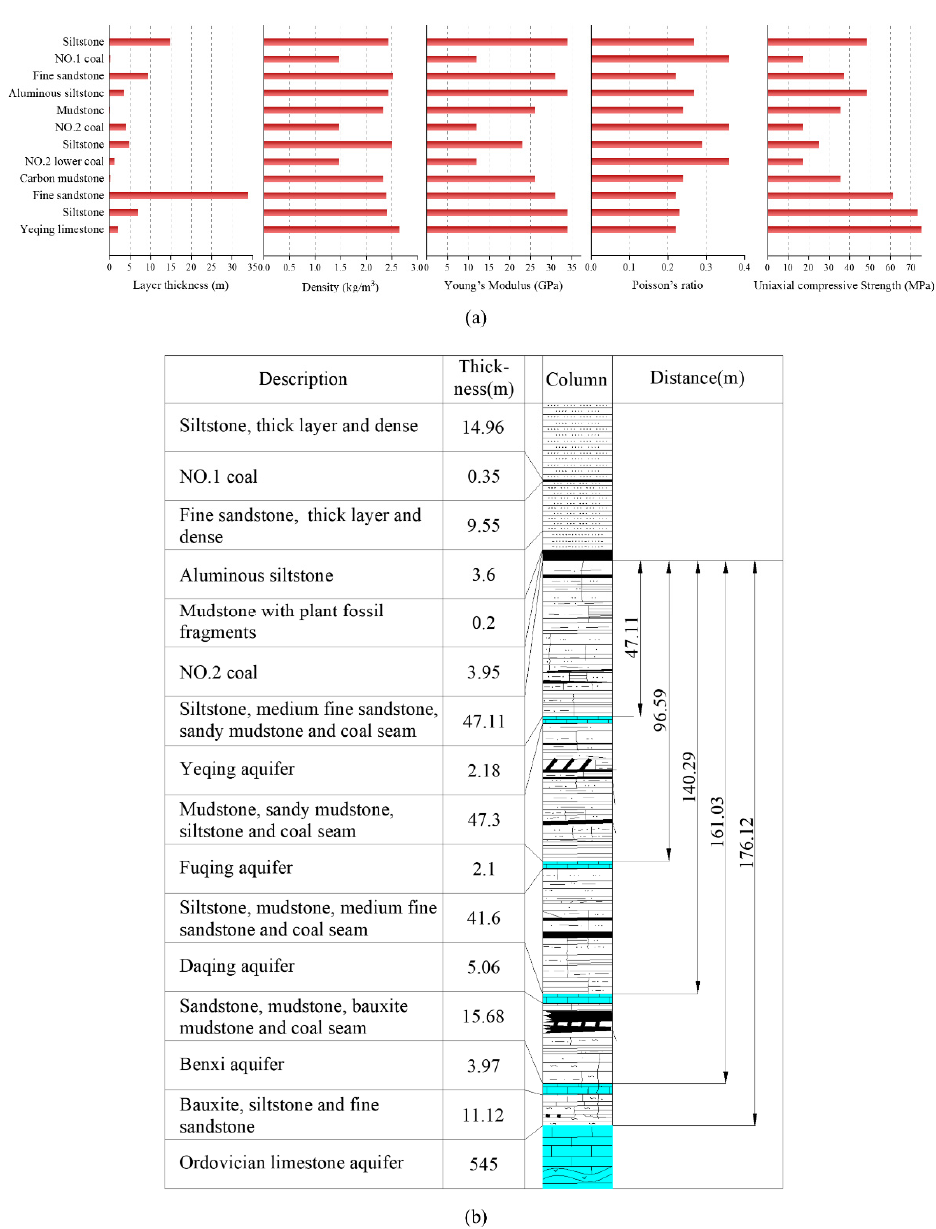
Figure 2. Geological conditions: ( a ) mechanical parameter of the coal seam and roof and floor strata; ( b ) comprehensive columnar schematic diagram.